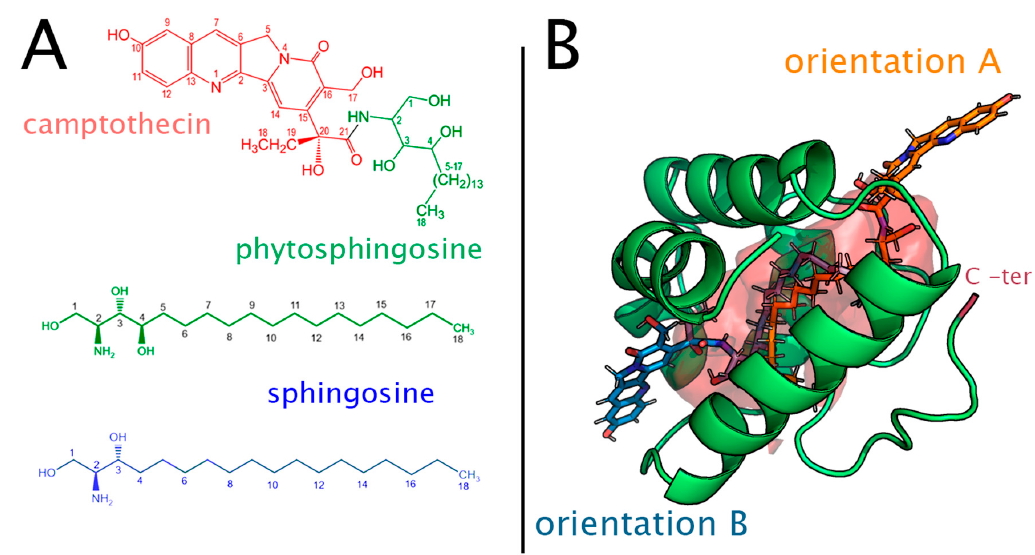
Figure 1. ( A ) Structural formulas of the ligands addressed in this work: the natural ligand of Pru p 3 (formed by the union of phytosphingosine and 10-hydroxy-camptothecin); phytosphingosine, and sphingosine. ( B ) Two possible orientations for the location of the ligand in the hydrophobic cavity (tunnel) of Pru p 3. The surface colored in red encloses the volume of a constant pocket inside the protein, obtained using MDPocket over molecular dynamics